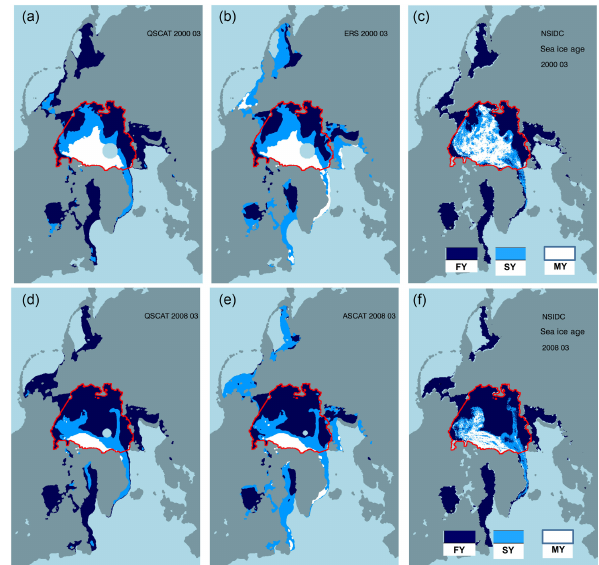
Figure 11. Geographical boundaries of wintertime FY (dark blue), SY (light blue) and MY (white) sea ice classes from Ku-band backscatter (left panel), C-band backscatter (middle panel) and NSIDC sea ice age (right panel) for 2000 (a, b, c) and 2008 (d, e, f) . The contour of the geographical mask used to delimit the Arctic Basin is shown in